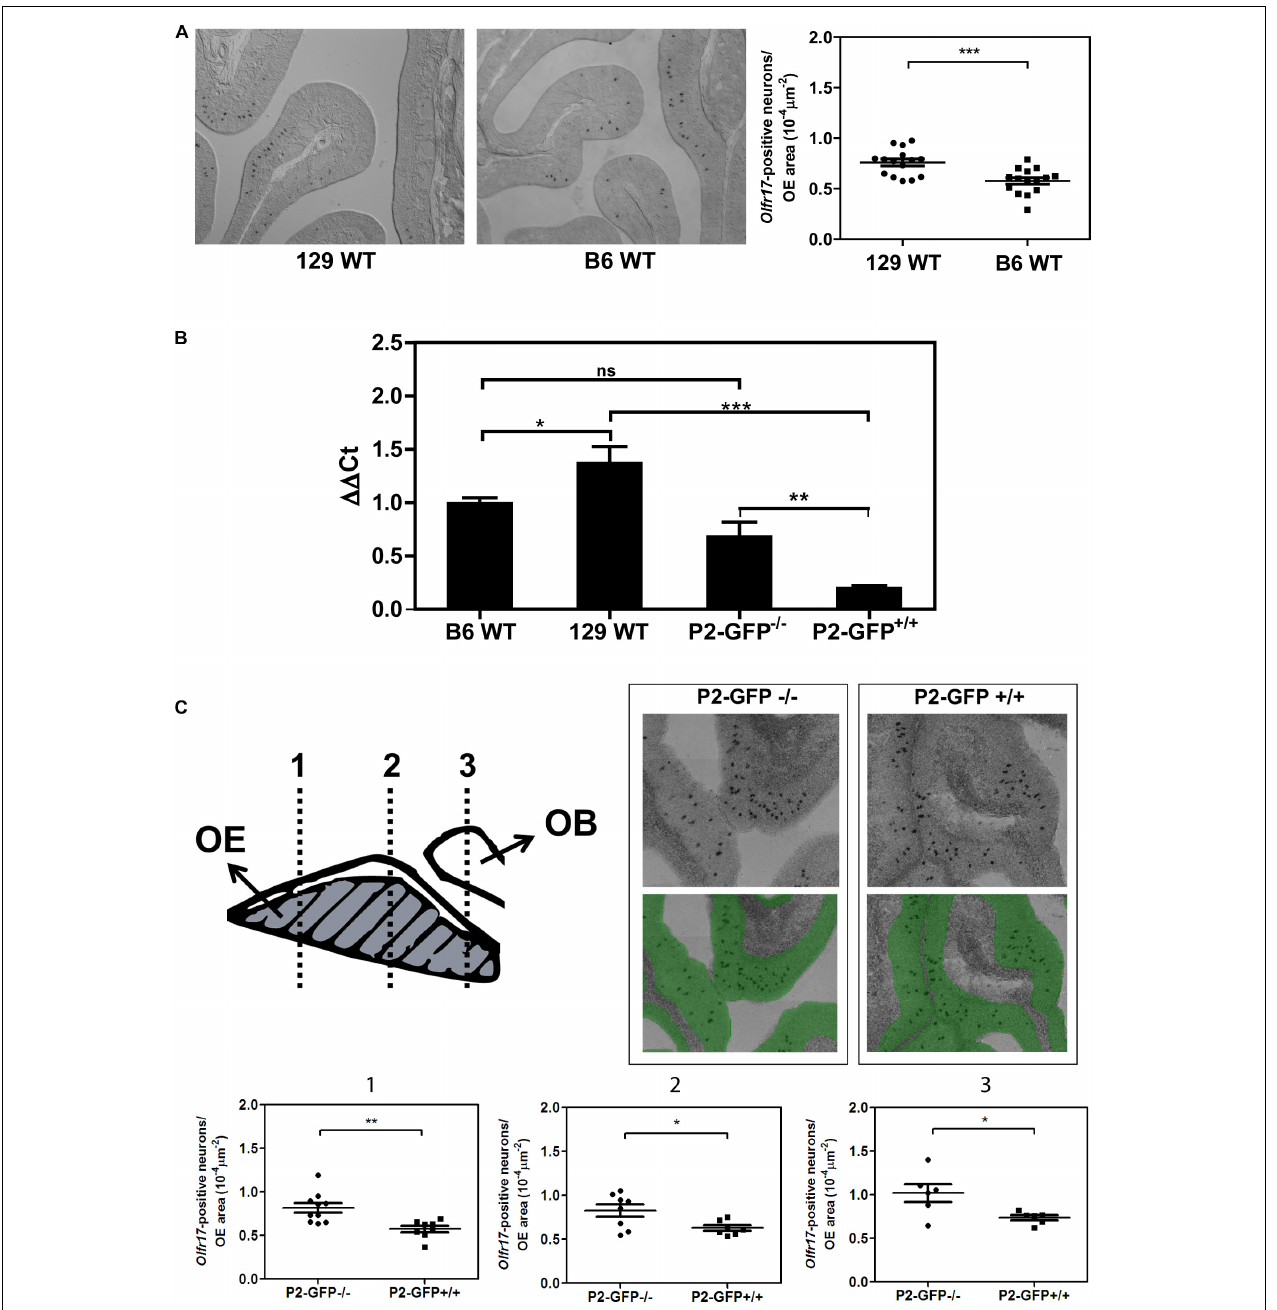
FIGURE 1 | Expression of the Olfr17 alleles in different genetic backgrounds. (A) Number of olfactory sensory neurons expressing Olfr17 in the wild type mouse strains. Coronal sections through the anterior-posterior axis of the olfactory epithelium from 129 and B6 mouse strains were hybridized with antisense digoxigenin-labeled probe specific for Olfr17 . Representative images of the labeled sections are shown. The graph shows the number of Olfr17 -positive neurons per olfactory epithelium area. N = 3 animals from each strain, five sections per animal. Student’s t -test *** P < 0.001. (B) RT-qPCR was performed to determine the relative Olfr17 gene expression levels in the olfactory epithelium from 129 and B6 wild type mouse strains, or from P2-GFP − / − and P2-GFP + / + knock-in siblings. The levels were normalized to β -actin and are shown relative to the expression in the wild type B6 olfactory epithelium. The graph shows mean +/ − SEM (B6, n = 3; 129, n = 4; P2-GFP − / − , n = 4; P2-GFP + / + , n = 4). Not significant: ns, * P < 0.05; ** P < 0.01 and *** P < 0.001. One-way ANOVA followed by Newman–Keuls post hoc test. (C) Coronal sections through the anterior-posterior axis of the olfactory epithelium from P2-GFP − / − and P2-GFP + / + mice were hybridized with antisense digoxigenin-labeled probe specific for Olfr17 . Olfactory neurons that hybridized with the Olfr17 probe were counted in 7–10 adjacent sections from each genotype from the three indicated locations using Tissue FAXS. Representative images of the labeled sections are shown on the top right. The number of labeled neurons (black dots) per olfactory epithelium area (labeled in green), was determined in each section. Student’s t -test, * P < 0.05 and ** P < 0.01. Dots and squares represent the number of Olfr17 -positive neurons per olfactory epithelium area in each section.